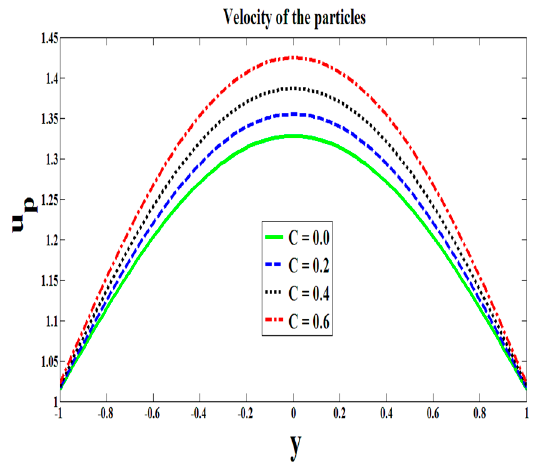
Figure 5. Effects of 𝐶 on the particles.